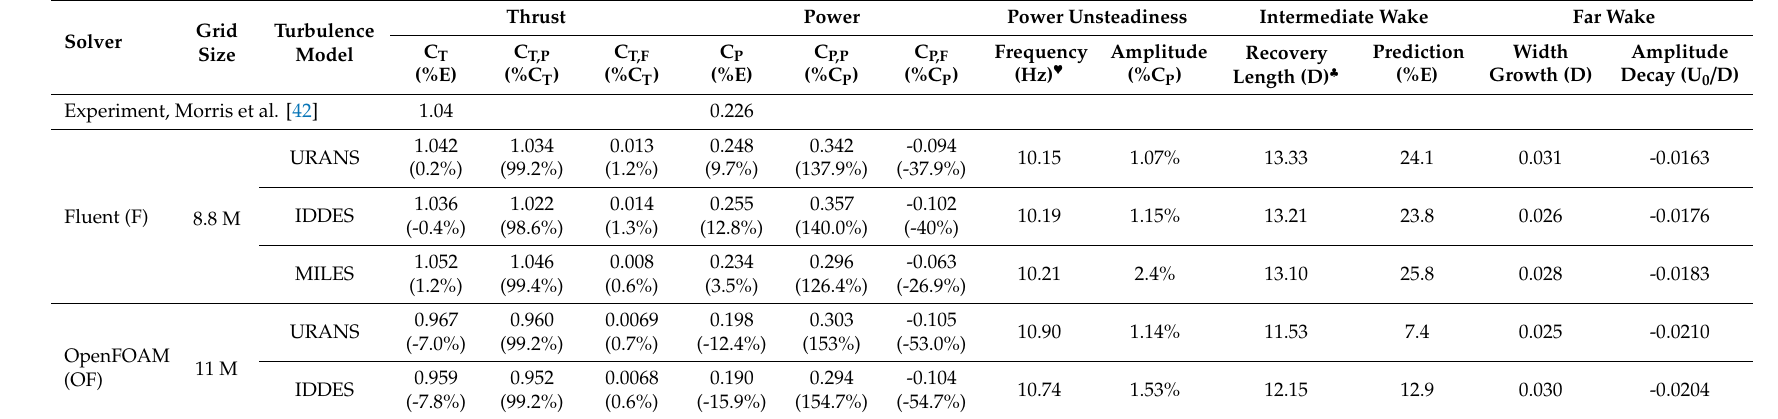
Table 1. Summary of thrust and power coe ffi cient, including contributions from pressure and viscous components, power unsteadiness, and wake recovery characteristics and prediction